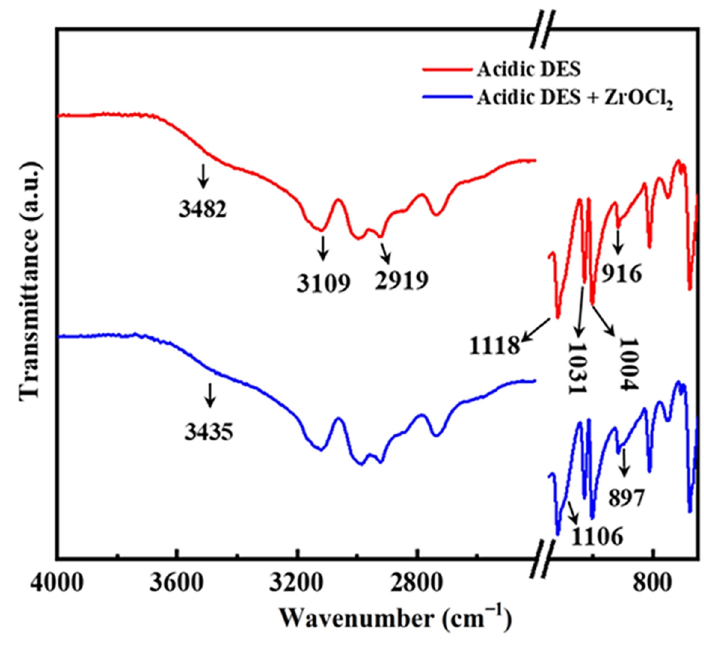
Figure 9. FT-IR spectra of acidic DES and acidic DES within ZrOCl 2 .